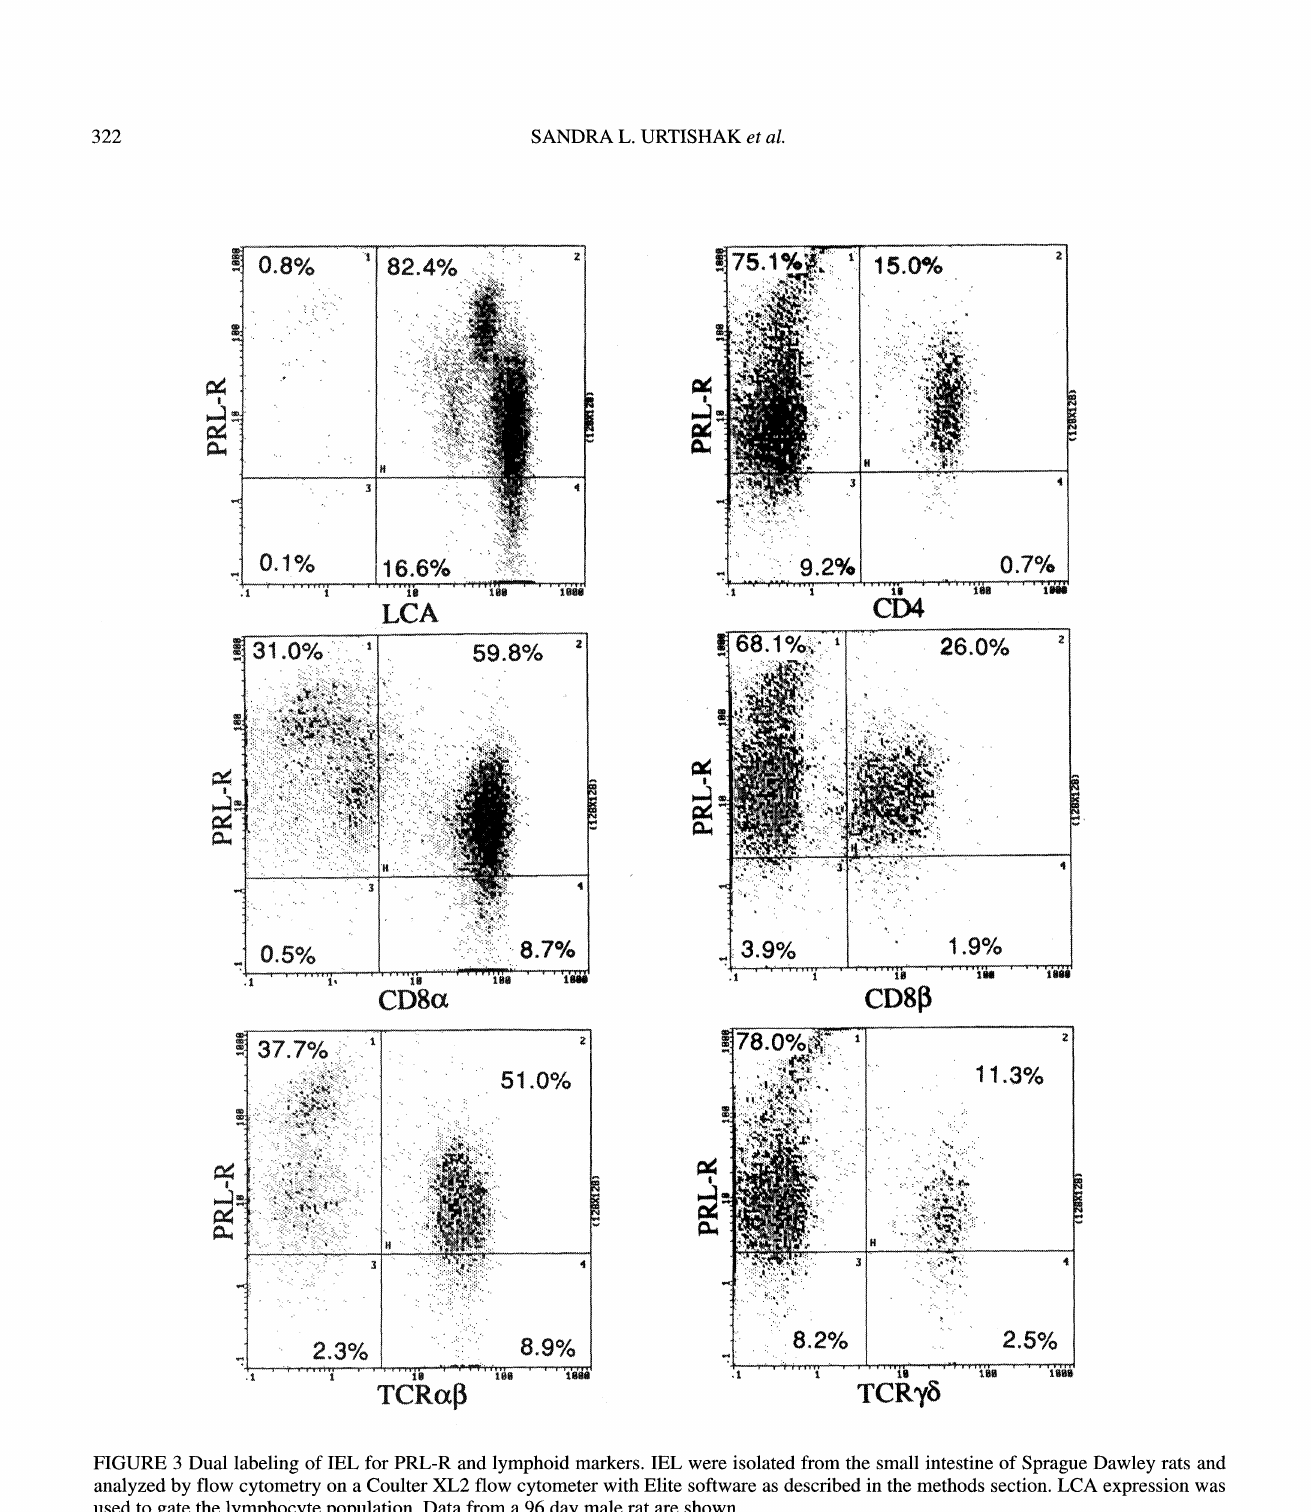
(8.9% _+ 2.6%) expression was lower (Table I, Fig.